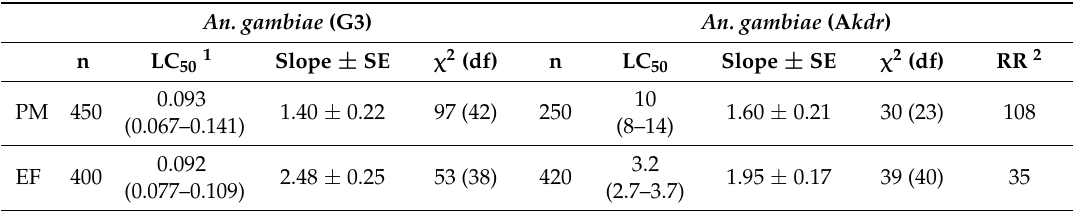
Table 2. Fourth-instar (intact) toxicity of permethrin (PM) and etofenprox (EF). An. gambiae (G3) An. gambiae (A kdr )